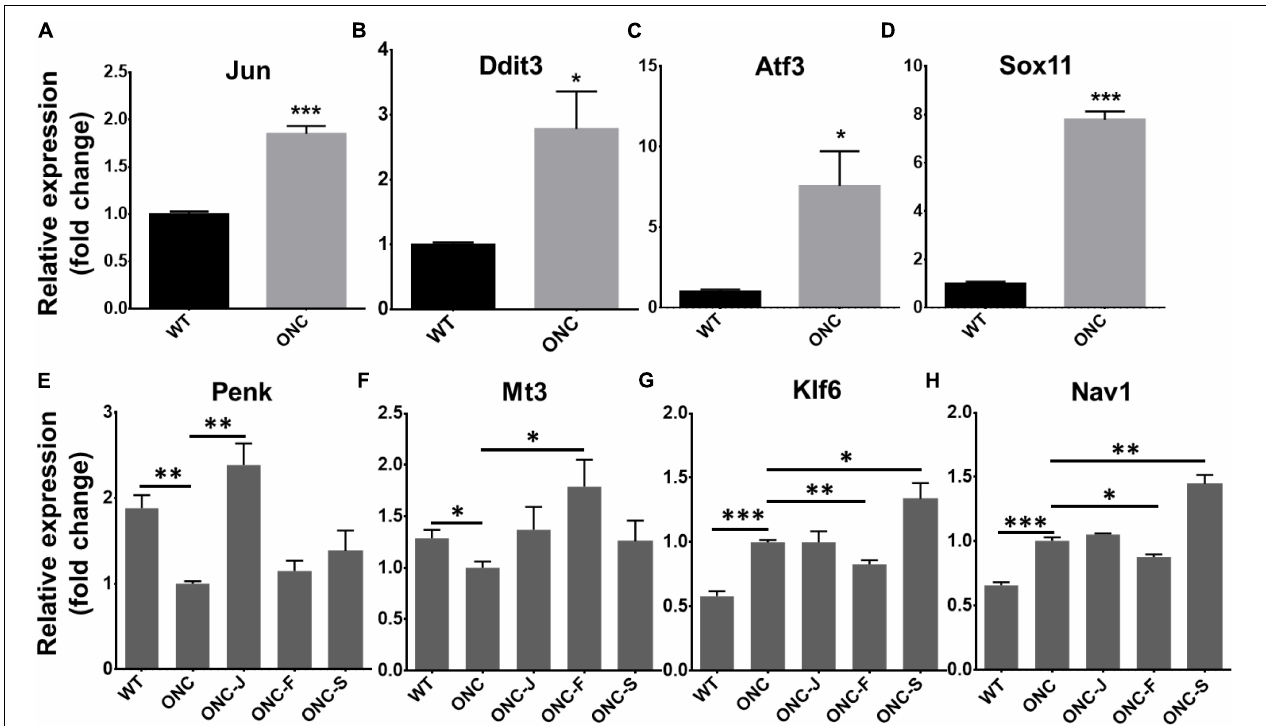
FIGURE 5 | Validation of selected TFs and DEGs with qRT-PCR. (A–D) Statistical graph shows fold change of TFs mRNA expression, normalized to GAPDH level. (E–H) Statistical graph shows fold change of mRNA expression of DEGs reversed by acupuncture treatment, normalized to GAPDH level. Data are represented as means ± SEM; n = 3; ∗ p < 0.05; ∗∗ p < 0.01; ∗∗∗ p <